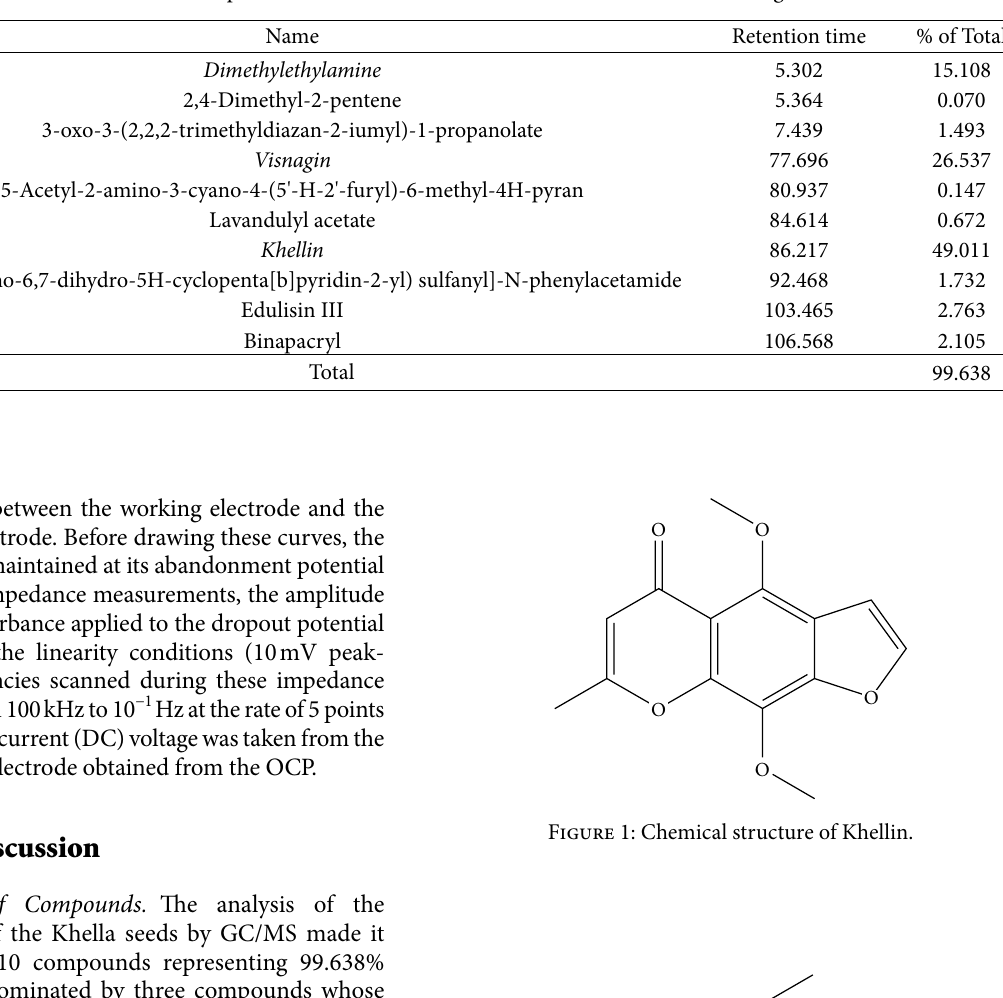
Table 2: Chemical composition of the methanolic extract of the seeds of Ammi visnaga .